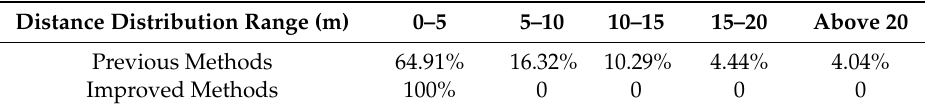
Table 5. Proportion of the deviation distance distribution range.